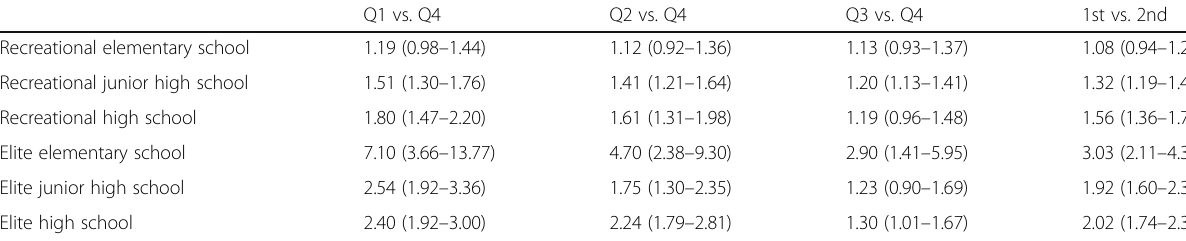
Table 4 Odds ratio and 95% confidence interval for each group